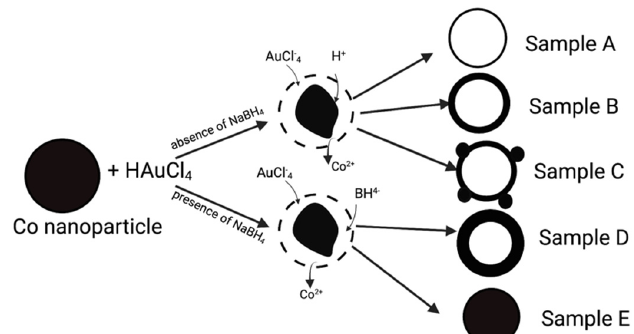
Figure 4. High resolution TEM images of hollow gold nanoshells templated from cobalt nanoparti- cle templates. ( a ) Lattice image of gold nanoshell showing the characteristic 0.235 nm lattice spac- ings of crystalline gold. Reprinted with permission from ref. [82], Copyright 2005 American Chem- ical Society. ( b ) Collection of cobalt-templated HGN showing spherical shapes with dark rims. ( c ) Higher magnification image of nanoshell. The dark rim and lighter interior is consistent with a gold shell structure. ( d ) Close-up of gold shell showing uniform shell thickness.